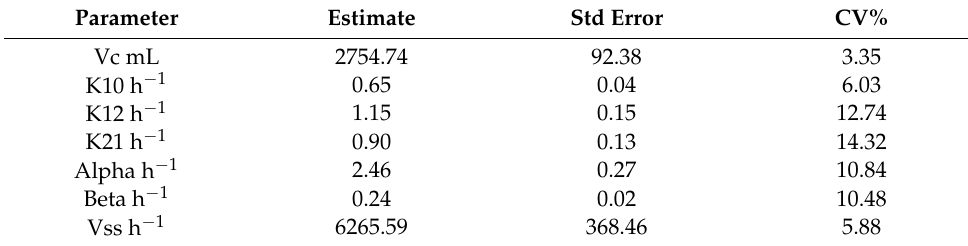
Table 2. Montelukast two-compartment pharmacokinetic parameters.